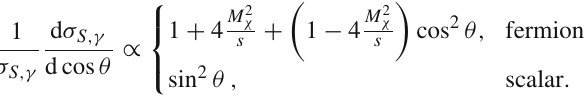
Table 4 Event selections in the two signal regions considered in the original work [63] Single track (1T) Double track